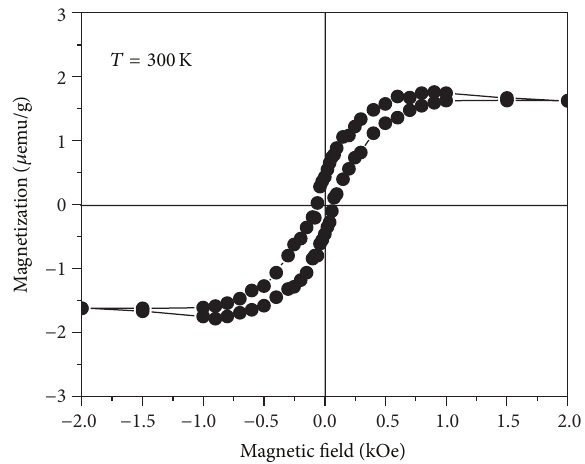
Figure 4: Magnetization hysteresis loops of ZnO nanorod arrays at 300